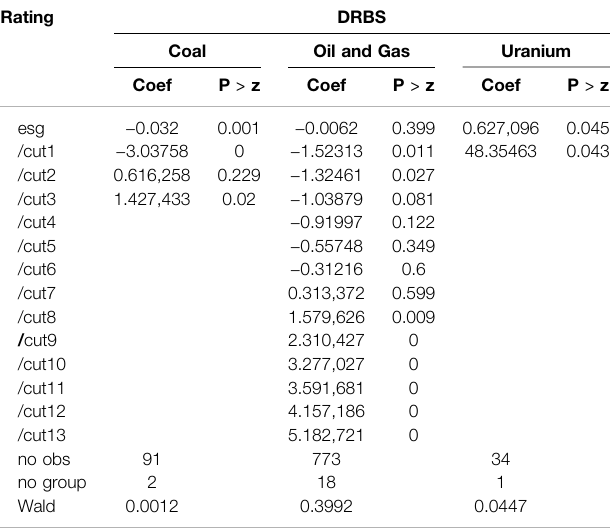
TABLE 6| Impact of ESG factors onDRBS long-term issuer credit rating changes according to sector division.